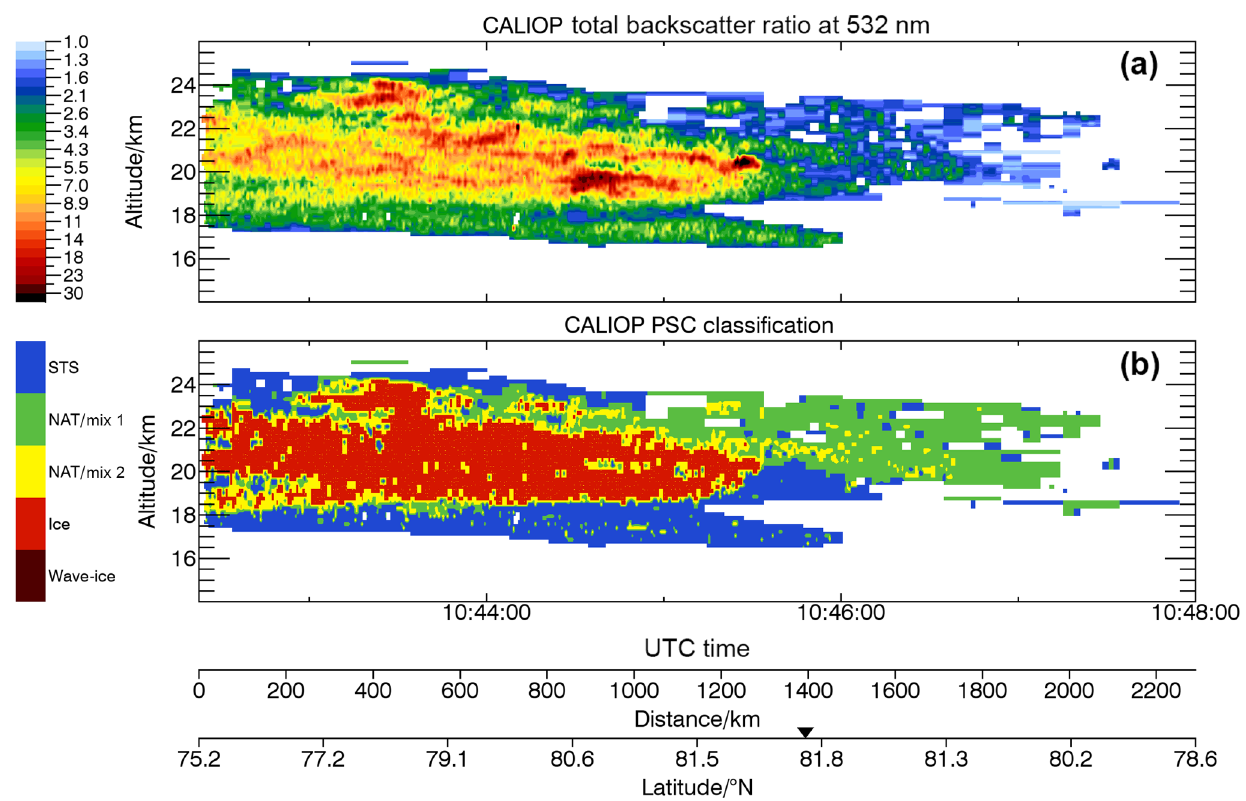
Figure 7. CALIPSO PSC measurements on 22 January 2016 near the HALO flight path. (a) Backscatter ratios from CALIPSO at 532nm wavelengths and (b) PSC type classification from Pitts et al. (2018). The time of the overpass between 10:42 and 10:47UTC as well as the horizontal distance and the latitude of the CALIPSO footprint are shown. The northernmost turning point of the CALIPSO footprint is marked by the triangle. The CALIPSO footprint is shown in Fig.